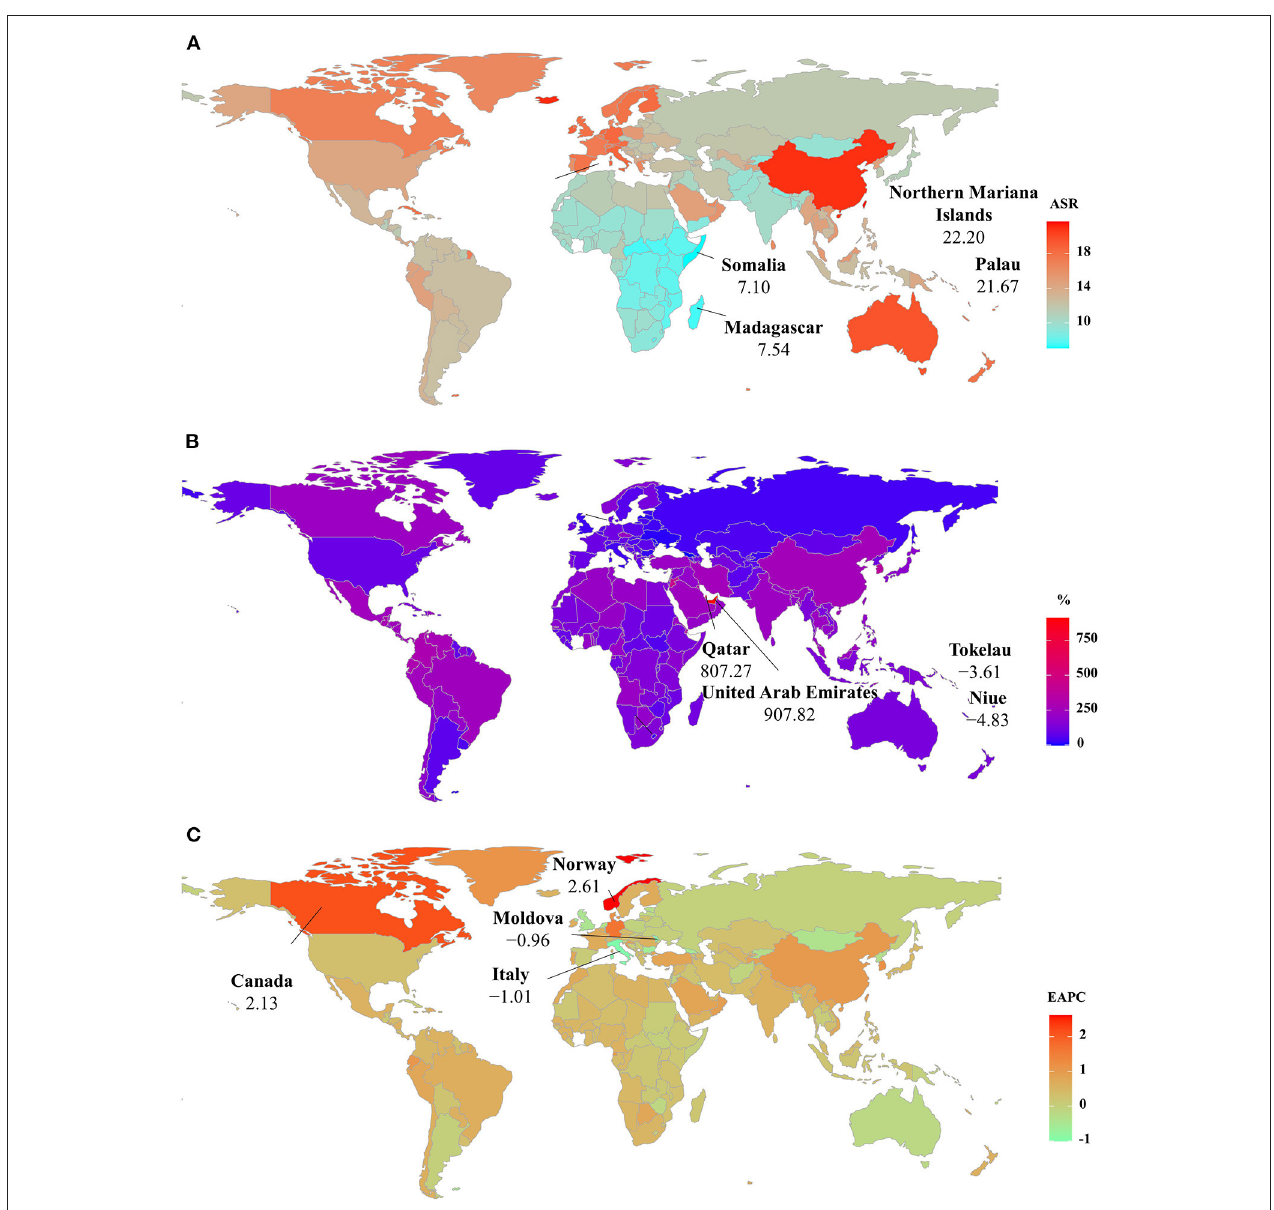
FIGURE 6 | The distribution of ASRs, percentage changes, and EAPCs of YLDs caused by Parkinson’s disease at the national level. (A) was the ASR in 2019; (B) was the percentage changes in number between 2000 and 2019; (C) was the EAPCs in countries/territories, respectively. Countries/territories with an extreme value were annotated. YLDs, years lived with disability, ASR, age-standardized rate; EAPC, estimated annual percentage